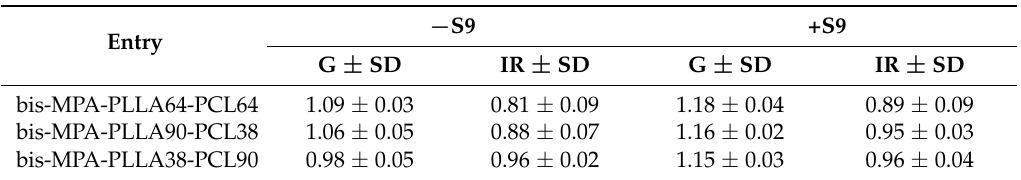
Table 3. The results of the umu -test for the highest concentrations of the tested branched copolymeric matrices extracts (0.66 mg mL − 1 ).